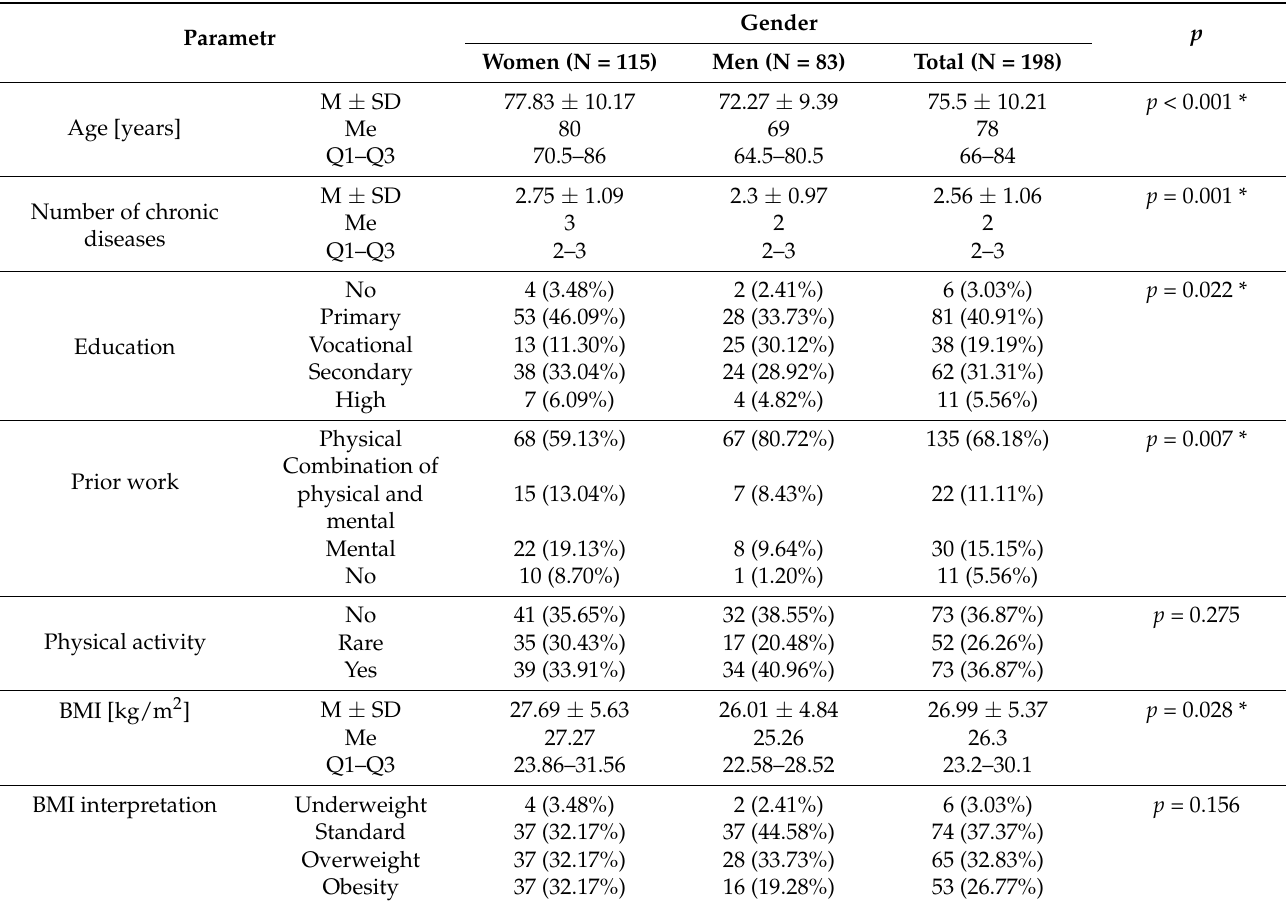
Table 1. The characteristics of a sample group.